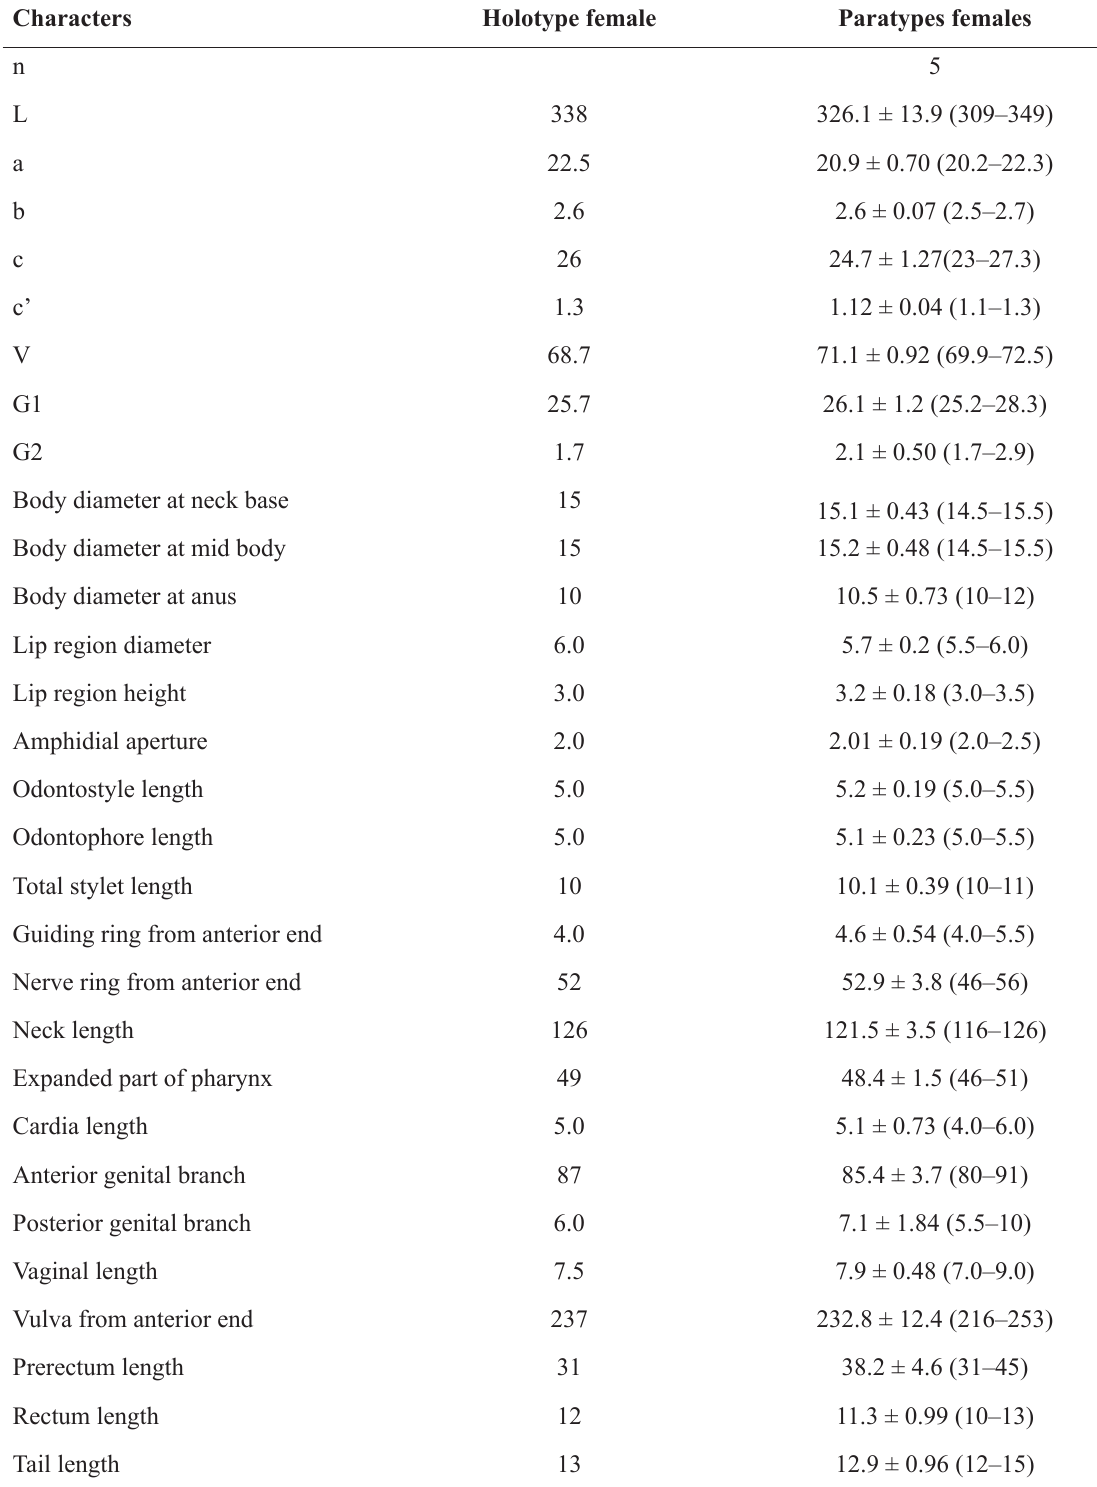
Table 9. Measurements of Tylencholaimus striatus sp. nov. All measurements are in µm and in the form: mean ± s.d.